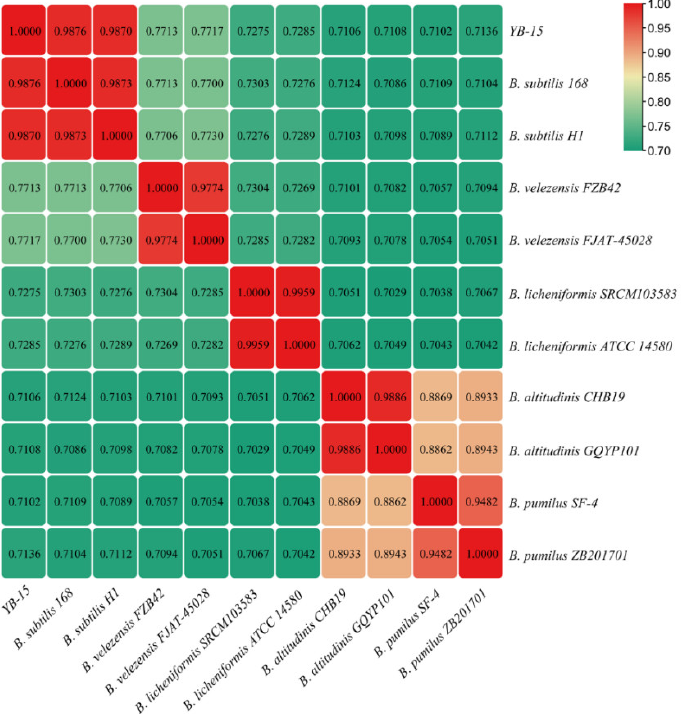
and reverse strand; ring 3 for GC skew in plus (green) and GC skew in minus (purple); ring 4 for